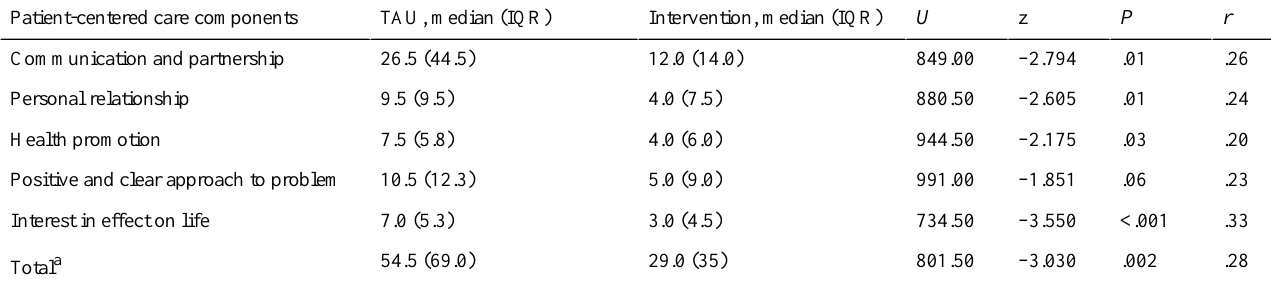
Table 6. Reported ratings of patient-centered care by patients in treatment-as-usual (TAU) (n=30) and intervention groups (n=85).